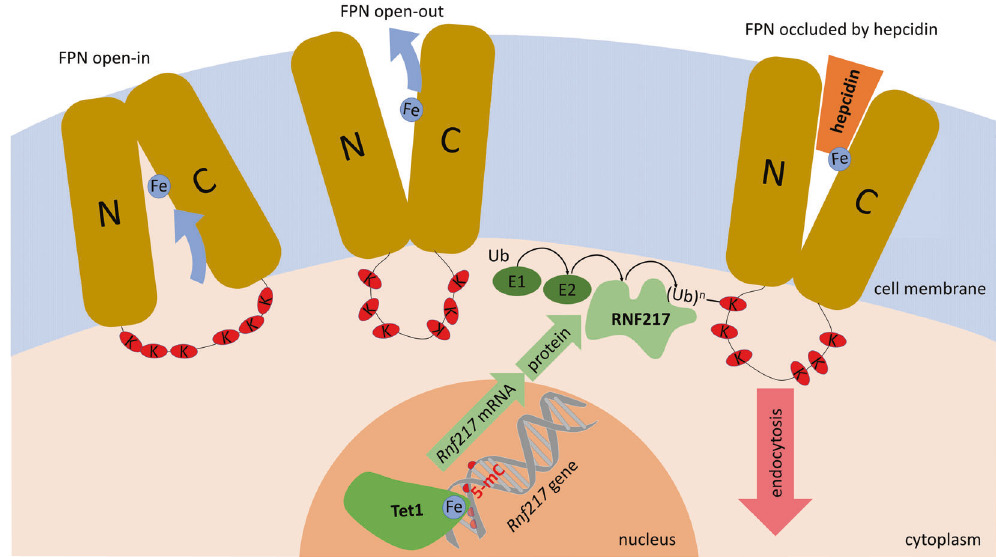
Fig. 1 A model of ferroportin (FPN) regulation by Tet1 and RNF217. When hepcidin is not bound to it, FPN exports iron through the alternating access mechanism. Based on available structural information, FPN is depicted as two six-helix transmembrane bundles (N- and C- lobe) enclosing a central cavity and connected by a cytoplasmic lysine-rich loop. Hepcidin binding to FPN triggers a conformational change that makes lysines (K) accessible to ubiquitination by the E3 ubiquitin ligase RNF217. Ubiquitination of FPN targets it for endocytosis and proteolysis. Cellular concentrations of RNF217 are in part controlled by the iron occupancy of Tet1, an iron-dependent dioxygenase that activates the transcription of the Rnf217 gene by demethylating its 5-methylcytosines (5-mC). In the presence of iron,